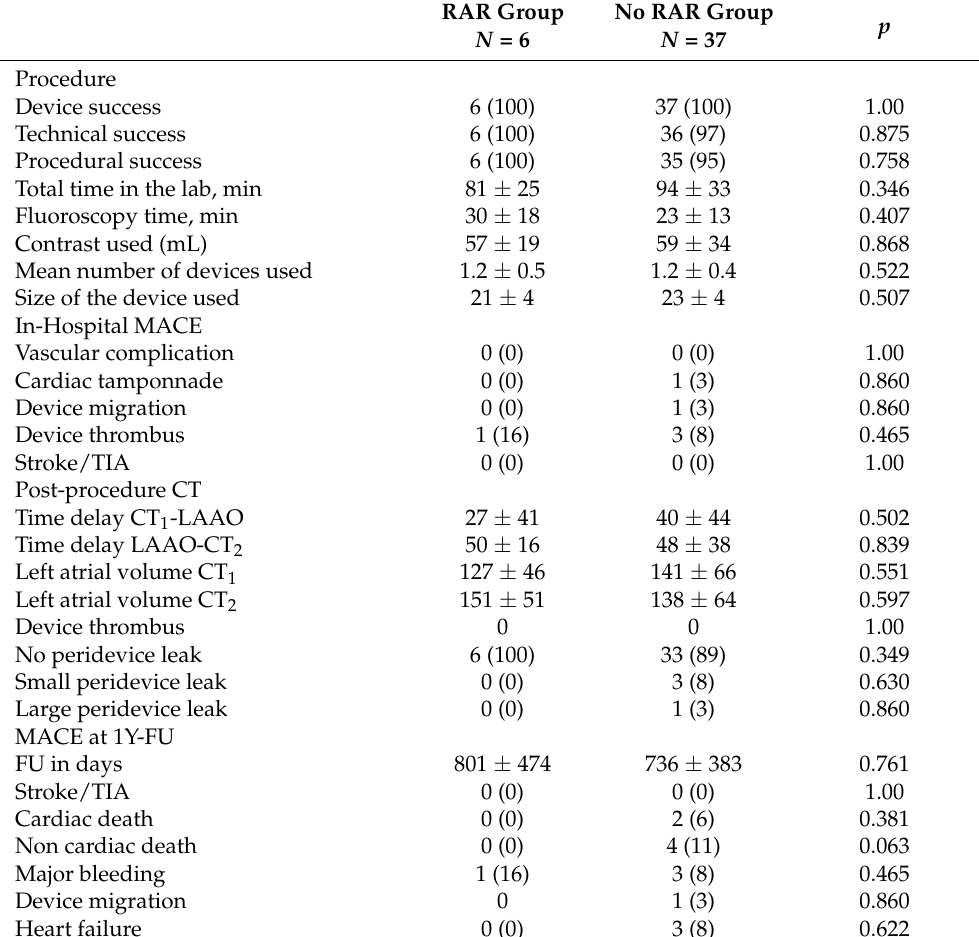
Table 2. Procedural and post-procedural characteristics (according to the presence or absence of reverse atrial remodeling).